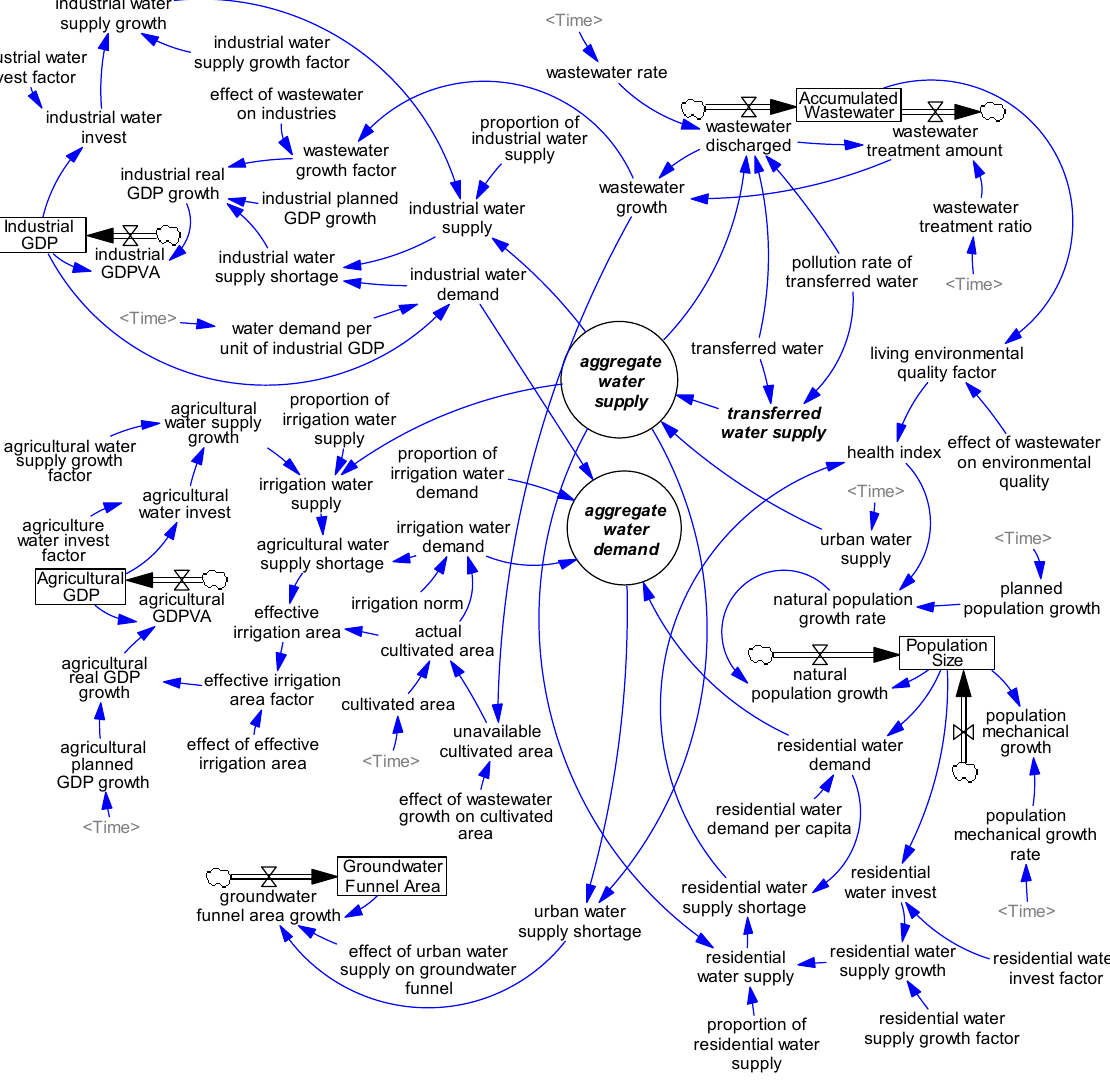
Figure 2. Causal pathways in the system dynamics